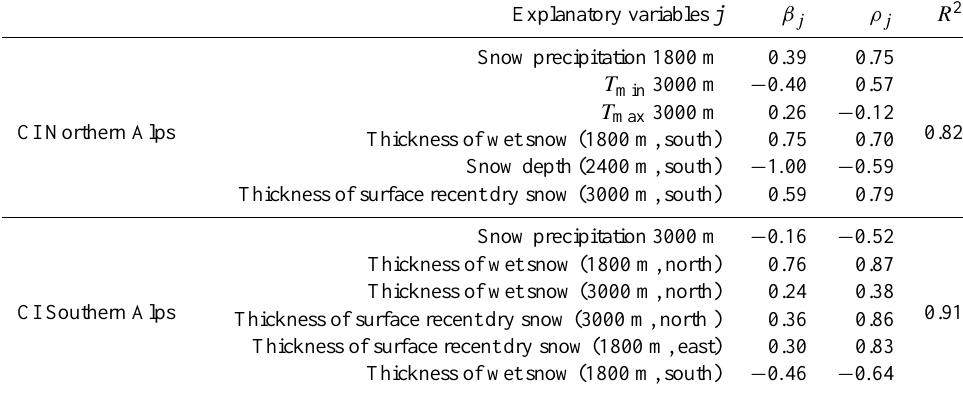
p P X norm .β j + ε t at the Northern and Southern French Alps scale for the annual anomalies of the Table 4. Regression models y t = jt j = 1 composite index CI. For each explanatory variable retained, X j , β j is the weighting coefficient, ρ j the correlation coefficient between X norm .β j and the response variable, and R 2 the determination coefficient of the jt